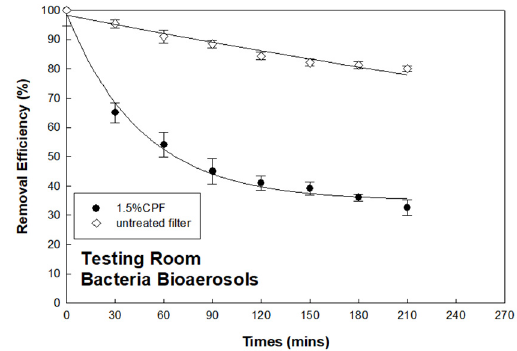
Figure 8. Survival of bacterial bioaerosols by using the 1.5% chitosan-coated and untreated filters in the testing room.